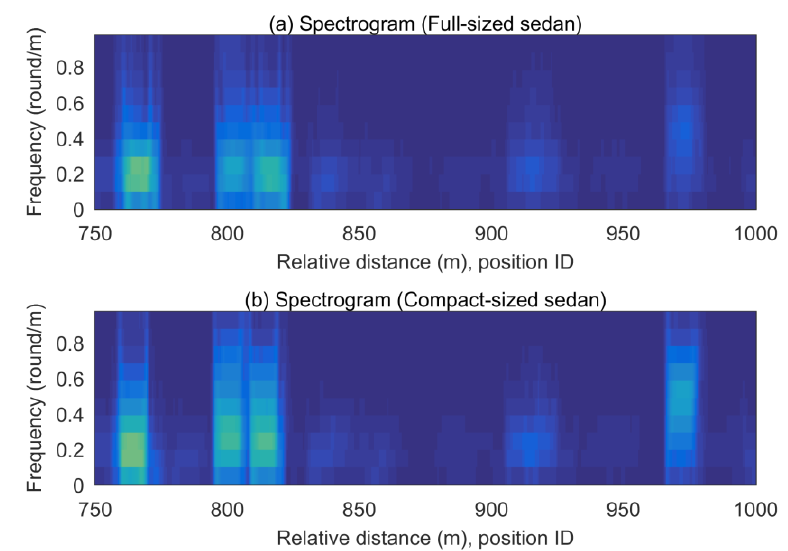
Figure 14. Estimated longitudinal road profile.